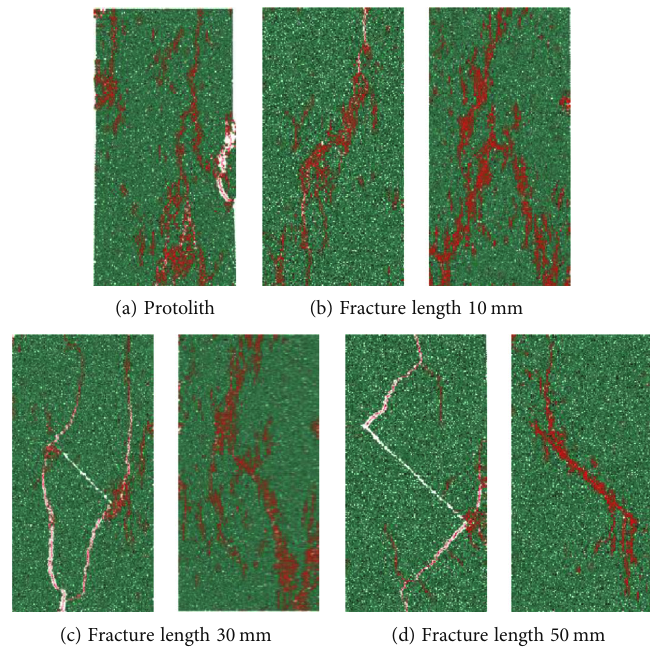
Figure 6: Crack distribution in the limestones with di ff erent prefabricated crack